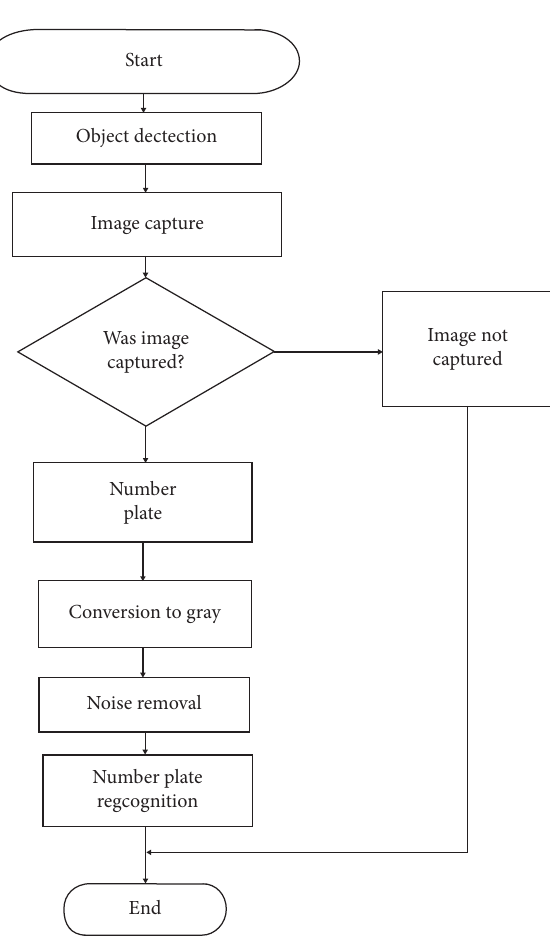
Figure 2: The system design